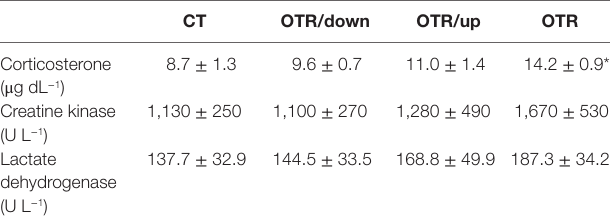
TaBle 1 | Responses of serum corticosterone ( μ g dL − 1 ), and activities of creatine kinase (U L − 1 ) and lactate dehydrogenase (U L − 1 ) in the CT, OTR/down, OTR/up, and OTR groups.